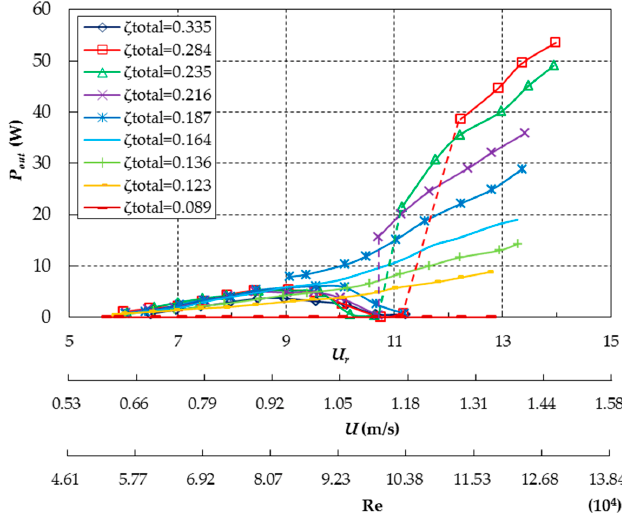
Figure 12. Harnessed power for different ζ system (Dashed lines denote hard excitation).